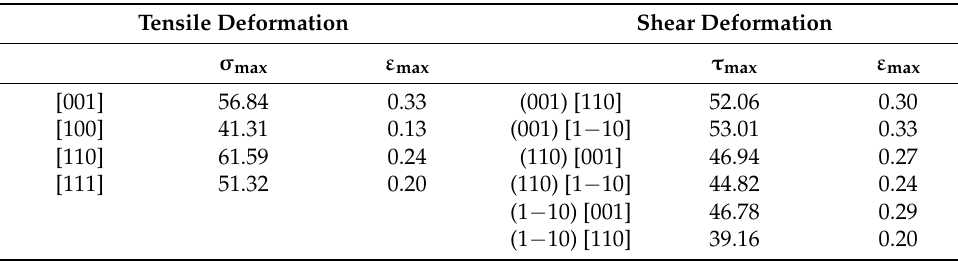
Table 1. Maximum tensile σ max and shear stresses τ max (in GPa) and their corresponding critical strain ε max values along different directions. The results are based on density functional theory (DFT) calculations using the generalized gradient approximation (GGA) functional.